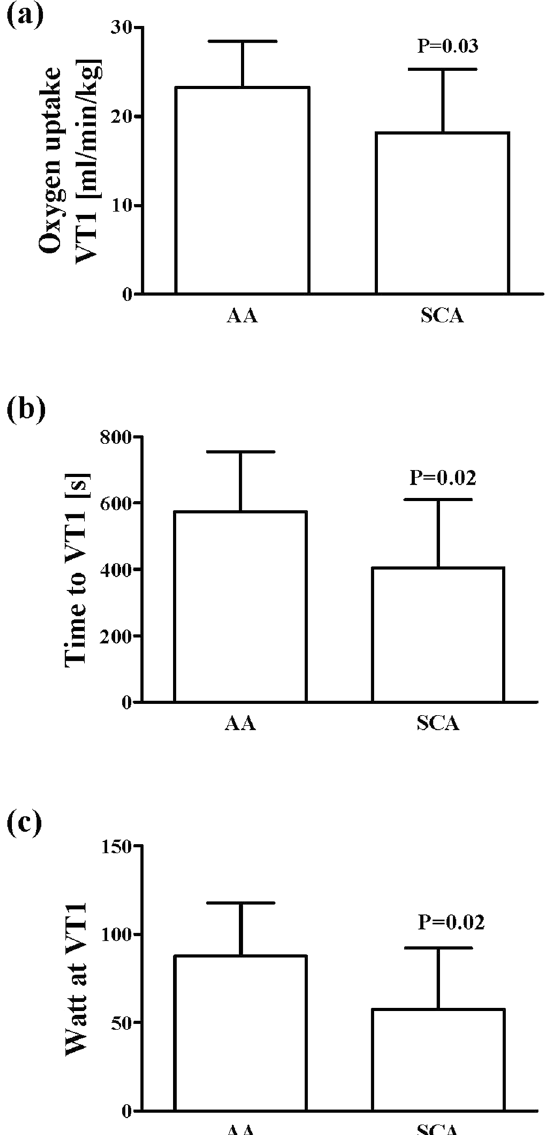
Figure 1. Reduced performance capacity in patients with sickle cell anemia. ( a ) Maximal oxygen uptake, ( b ) time to first ventilatory threshold (VT 1) and ( c ) watt power at VT 1 were significantly reduced in sickle cell patients (SCA) compared to healthy controls (AA). Data are mean ± s.d. of n = 8 AA and n = 8 SCA.